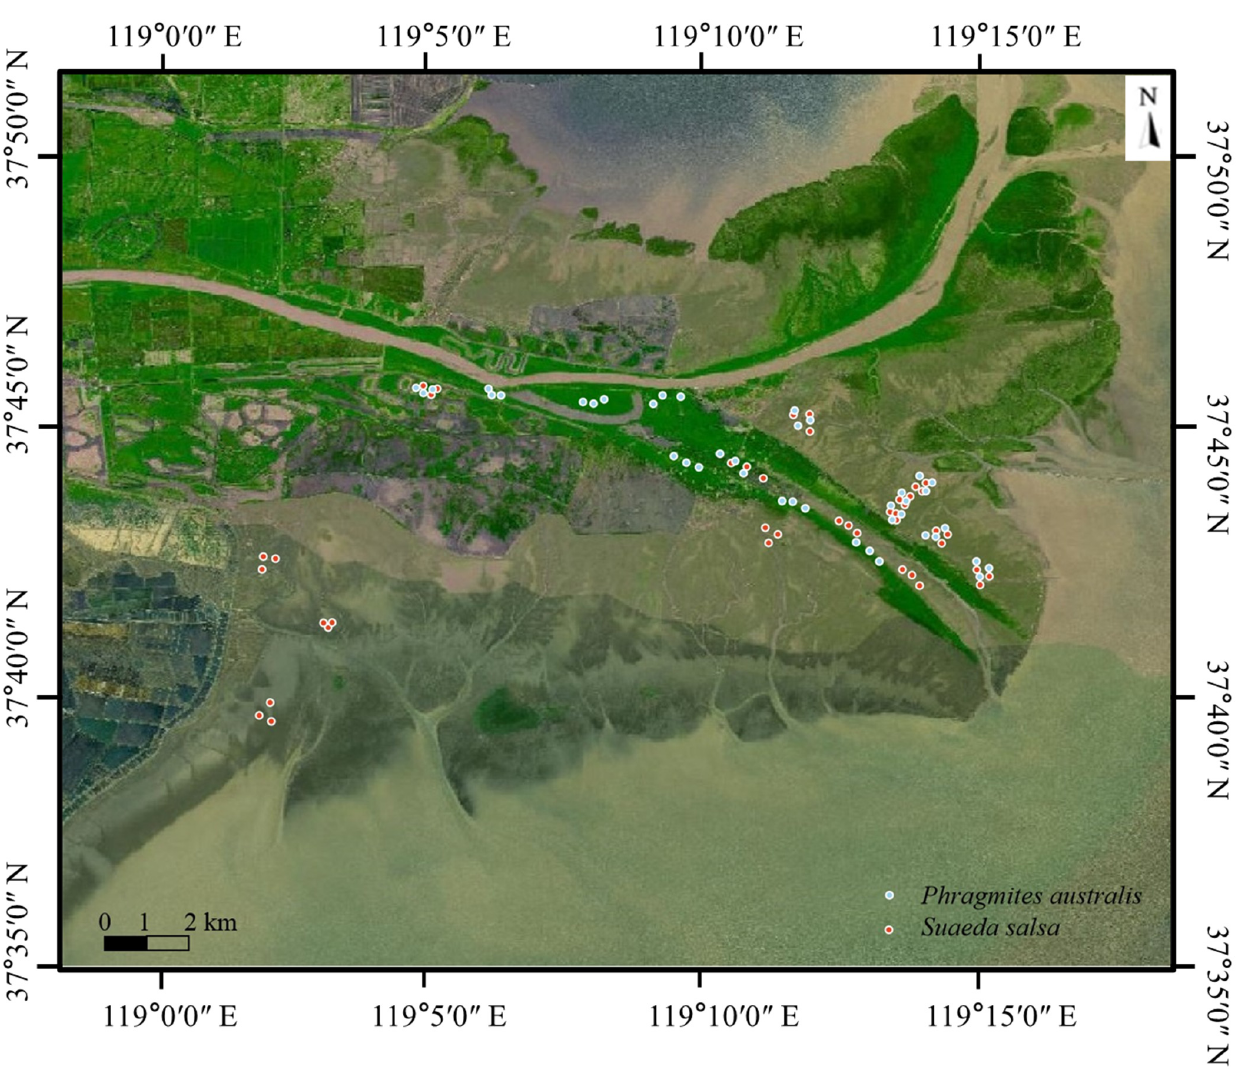
Figure 1. Location of the study area and sampling sites.